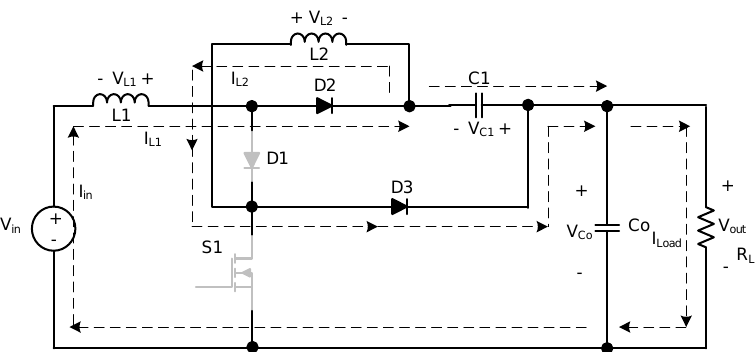
Figure 3. Voltage polarities and current directions in Mode 1.